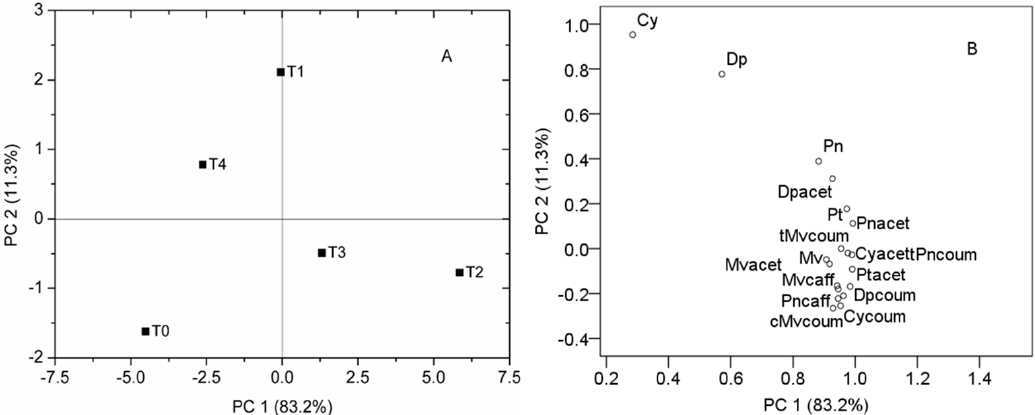
Figure 1. Principal component analysis (PCA) based on the correlation matrix of anthocyanins. Score plot ( A ) and loading plot ( B ). Abbreviations used in plot ( B ) are shown in Table 2.